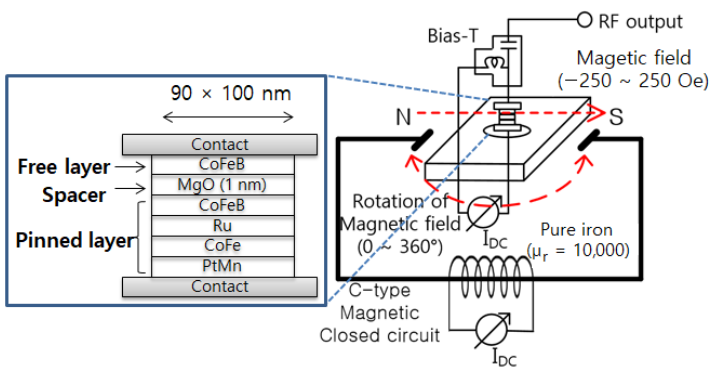
Figure 1. A block diagram of a fabricated STNO structure, and the measurement setup. A stacking structure of Co 6 Fe 2 B 2 (2 nm depth) is deposited on the synthetic structure pinned layer by a magnetron sputtering process as a free layer. The pinned and free layers are separated by a thin MgO (1 nm depth) layer as a tunnel barrier. All of the stacked layers are manufactured by a single deposition process. After an e-beam masking process, ion milling etching process is carried out, and the etch is stopped in the middle of the CoFeB pinned layer. At that time, the junction size is decided as 90 × 100 nm 2 . A post annealing process is carried out over 30 min at 300 ◦ C, under a 4 kOe magnetic